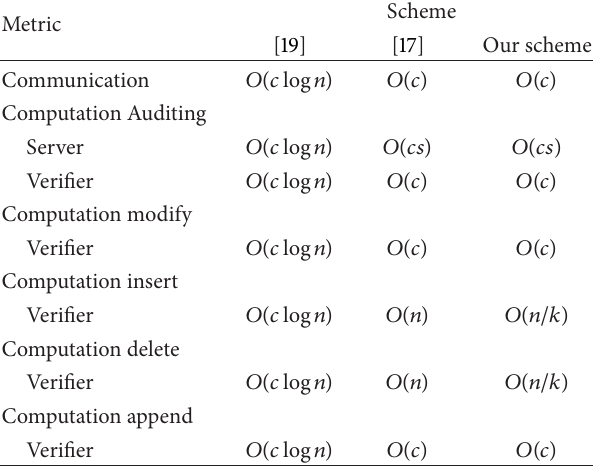
Table 1: Comparison of different remote data auditing